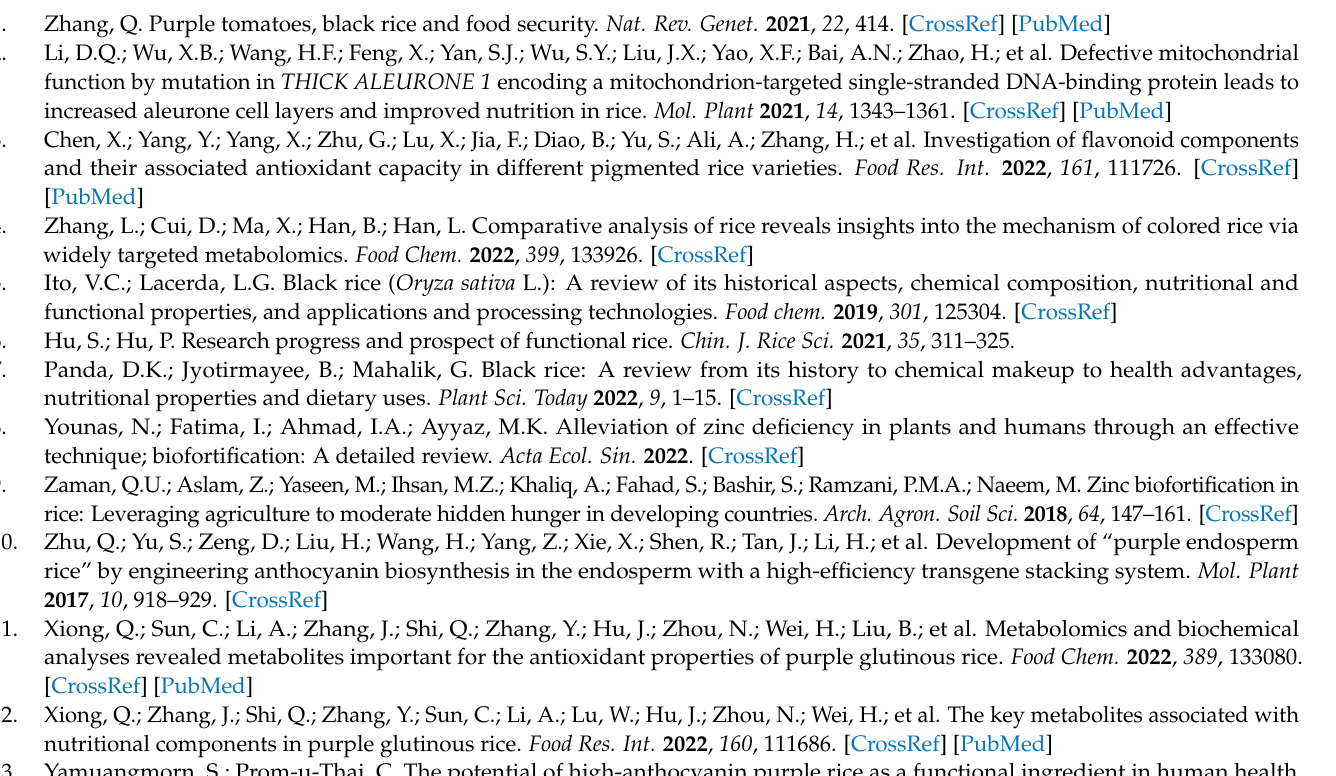
YZN2_H3. Table S1: Linear equations for the twenty-two amino acids; Table S2: Linear equations for